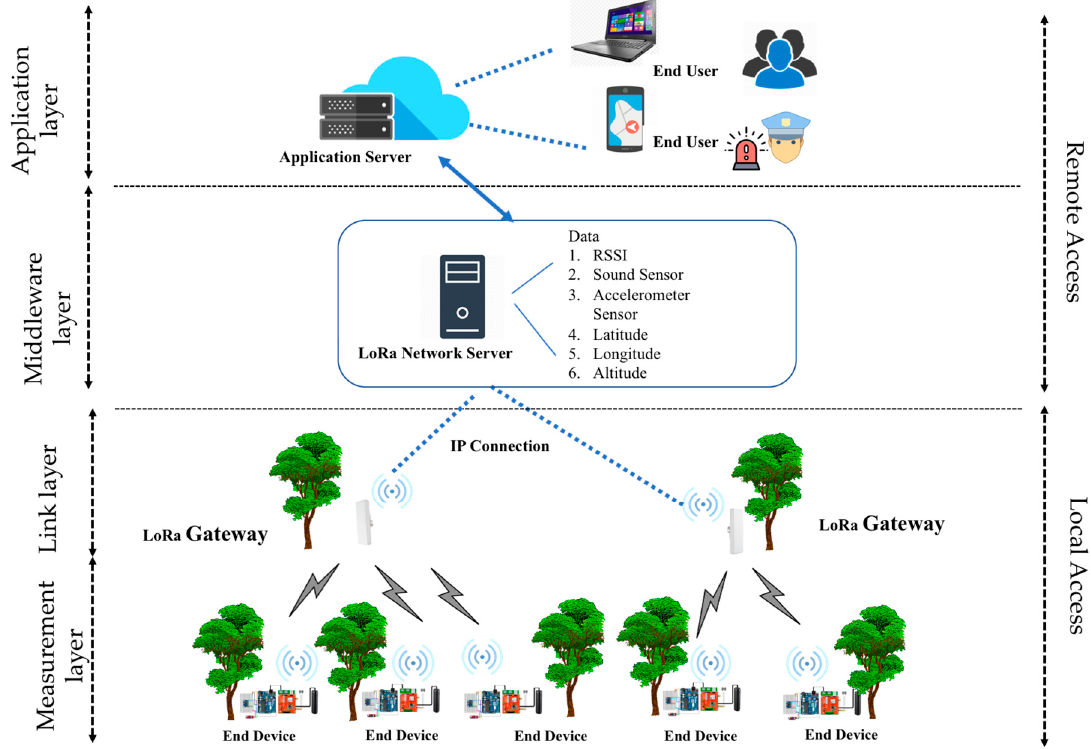
Figure 5. Architecture of LoRa Network in the Proposed System.